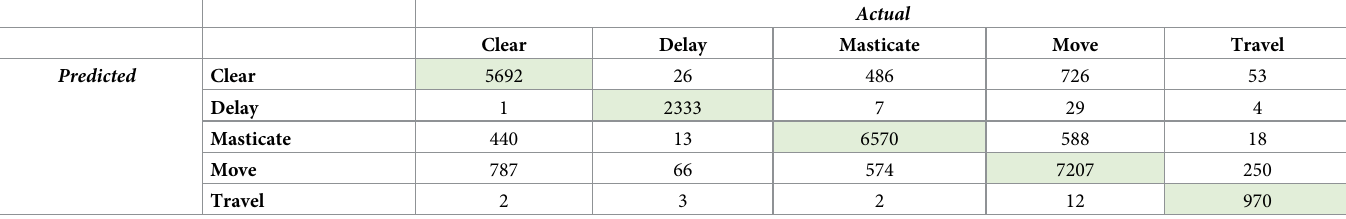
Table 4. Confusion matrix. Confusion matrix for the best performing activity recognition model (50 Hz sampling rate, 10 second window, 90% window overlap) indicat- ing true positives (TP), true negatives (TN), false positives (FP), and false negatives (FN).